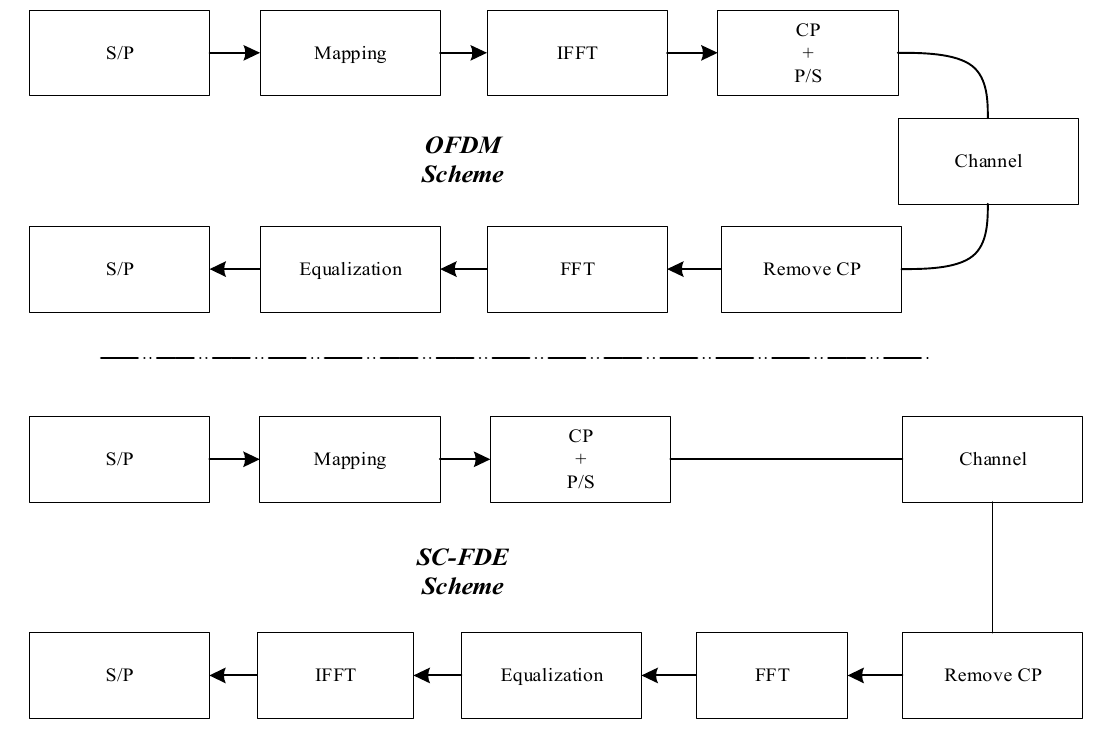
Figure 1. OFDM and SC-FDE schemes. Note the change of IFFT position between OFDM and SC-FDE. In SC-FDE pilot schemes, values have a variation compared with other modulations. For example, OFDM can have a symbol full of pilots (all the subcarriers with the same value). In contrast, SC-FDE needs to have different pilot values due to the FFT, which converts these values to zero. Therefore, the root Zadoff-Chu sequence must be used, which is a sequence that presents different values but in-module are the same value